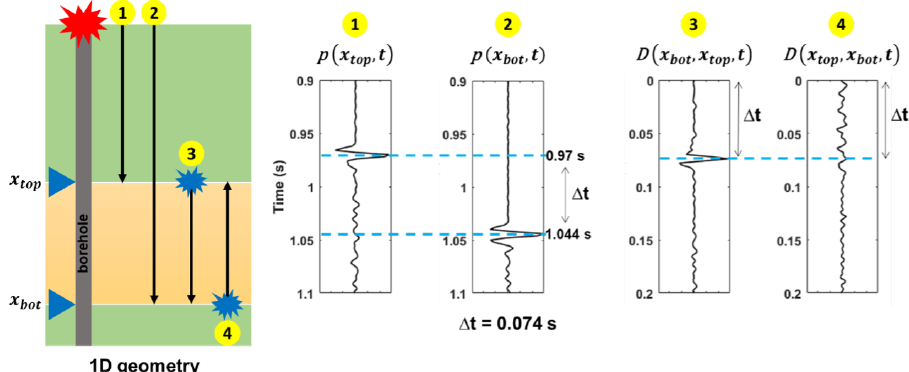
Figure 1. Illustration of 1D seismic interferometry with a synthetic active source at the surface. Black arrow depicts a wave path from the corresponding source. x is the geophone location at the top and bottom (subscripts top and bot). (1) Response observed by geophone at x top from excitation at the surface. (2) Response observed by geophone at x bot from excitation at the surface. (3) Estimated response observed at x bot as if we have a virtual source at x top . (4) Estimated response observed at x top as if there is a virtual source at x bot